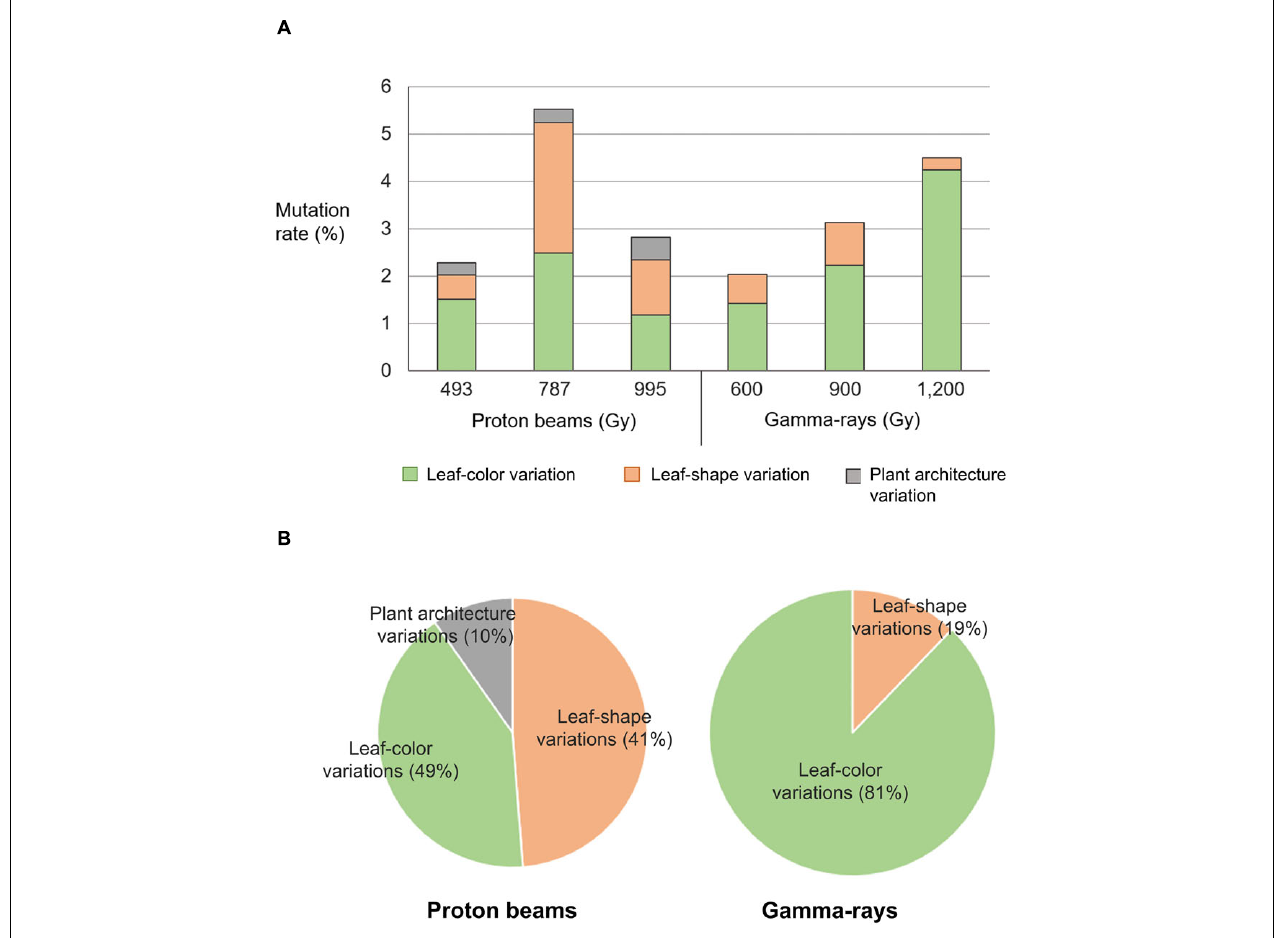
FIGURE 3 | Classification of mutant phenotypes detected in M 2 lines derived from proton beam and gamma-ray irradiation. (A) Mutation frequency in M 2 lines classified by types of mutant phenotypes. (B) Ratio between mutation frequencies of M 2 lines classified by types of mutant phenotypes.